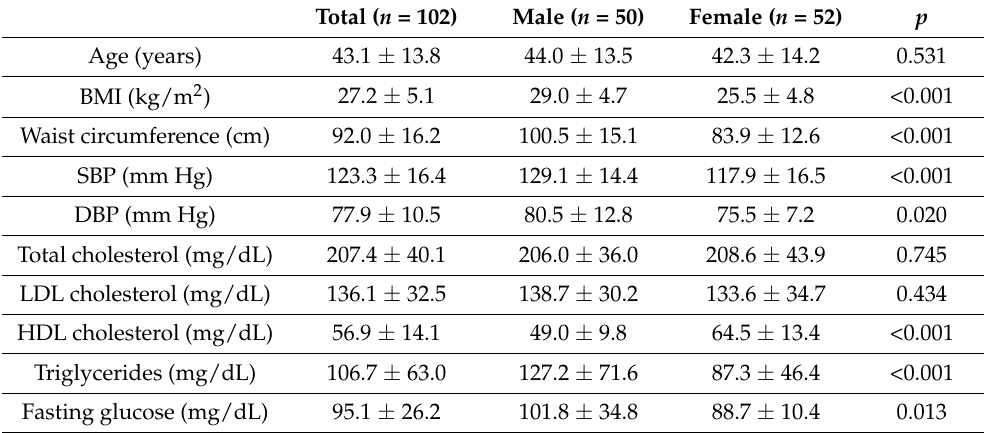
Table 1. General characteristics of the study